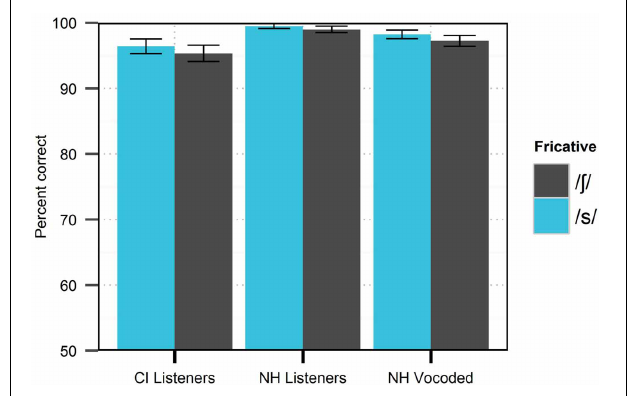
(cid:2) / stimuli at